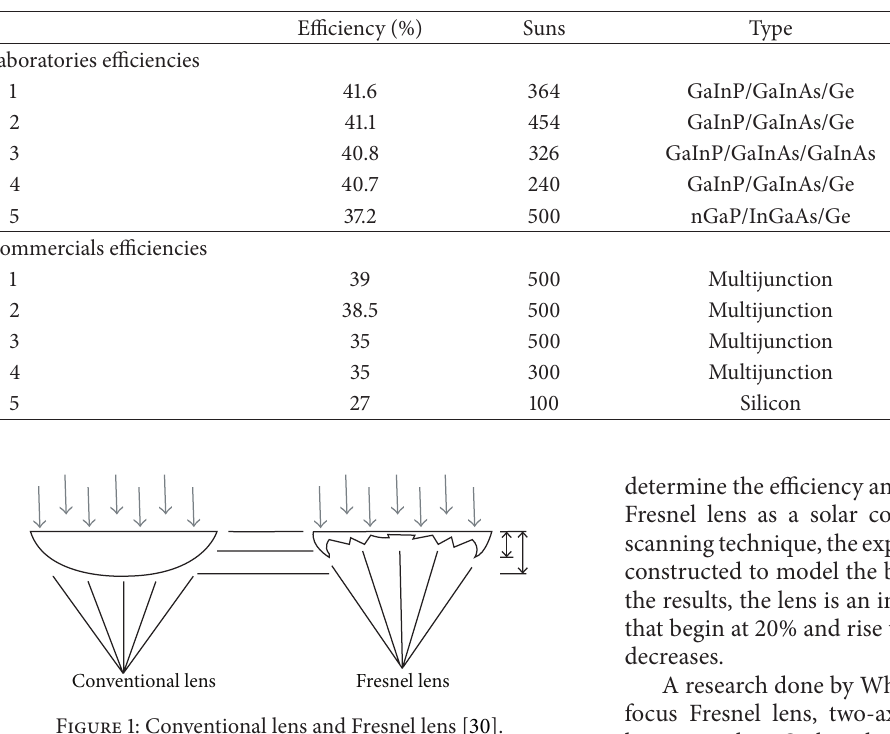
Table 2: Different HCPV efficiencies recorded in Laboratories and commercials [24].